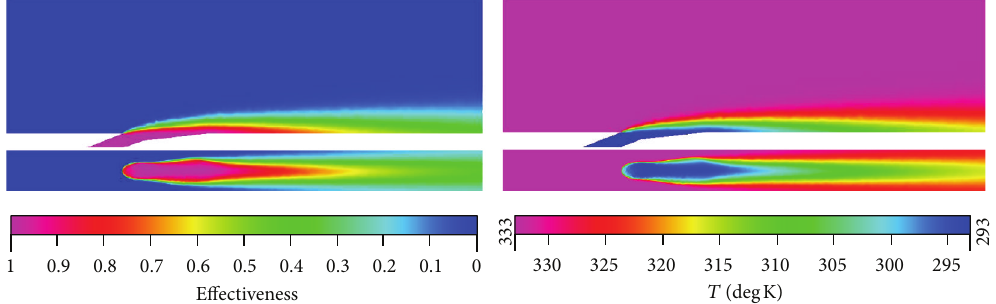
Figure 32: Effectiveness and temperature contours of flat plate film cooling for optimum hole shape.